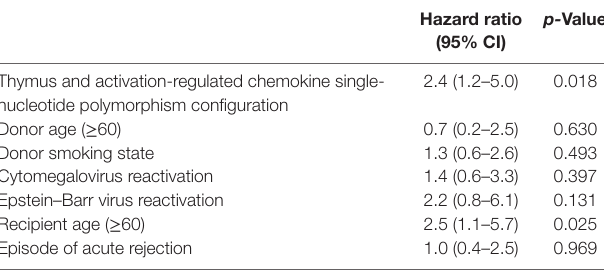
Table 3 | Multivariate analysis on bronchiolitis obliterans syndrome (BOS) incidence in patients treated with lung transplantation.